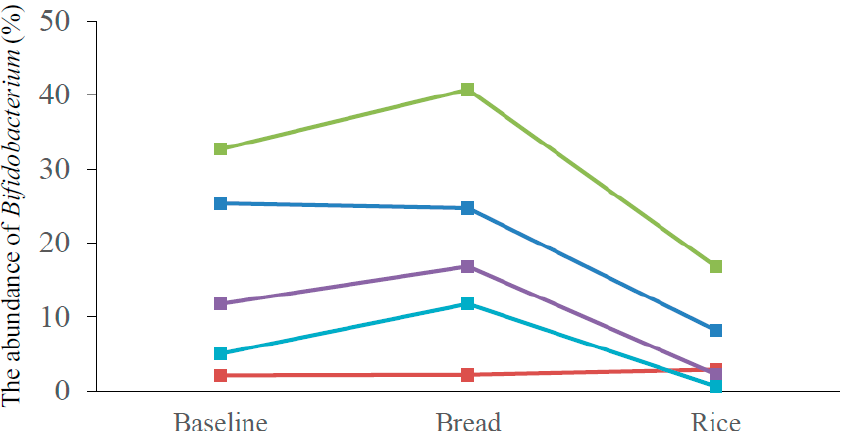
Figure 2. Phylum -level classification of bacteria identified in fecal samples of five subjects. The phyla represented by the different colors are shown below the figure. Baseline: Base; After bread period: Bread; After rice period: Rice. Table 3. Mean value of genera of the Actinobacteria phylum identified in fecal samples at baseline, and after bread and rice periods. Baseline ( n = 7)